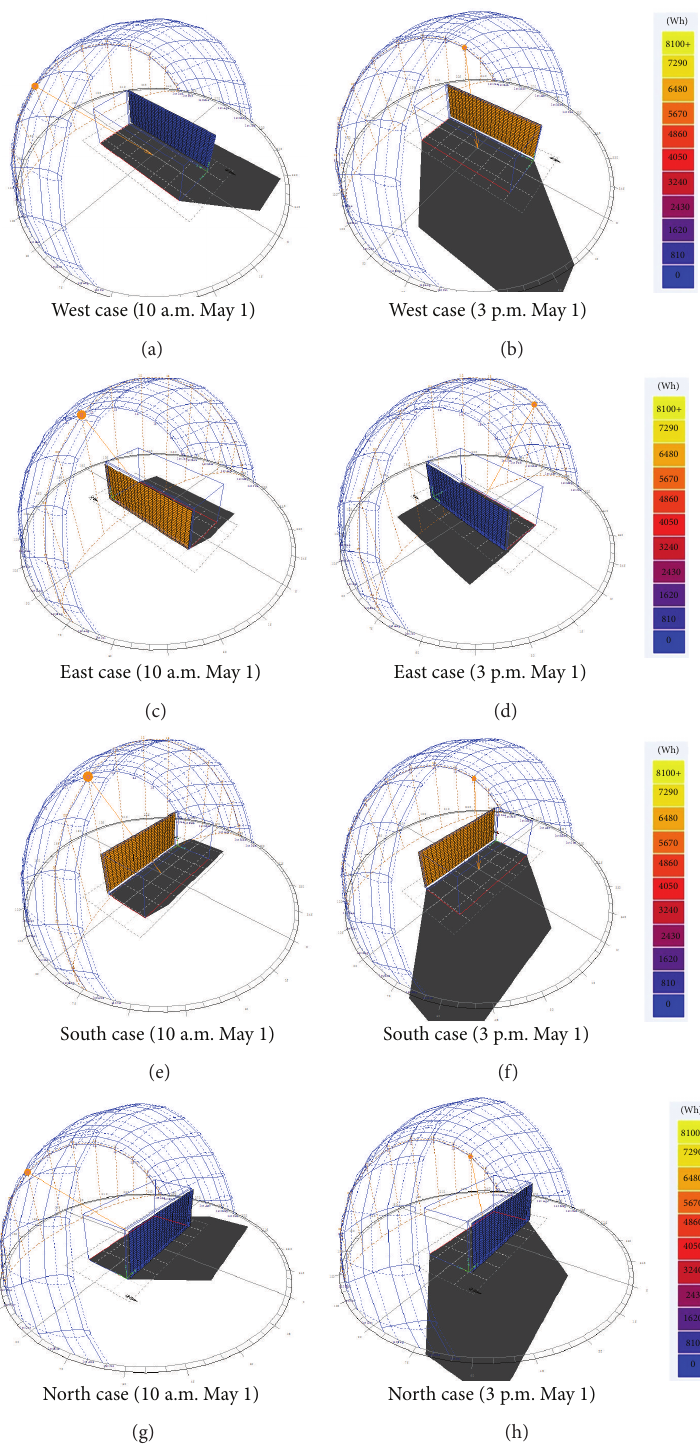
Figure 9: Solar trajectory and irradiation intensity of (a), (b) west, (c), (d) east, (e), (f) south, and (g), (h) north cases.